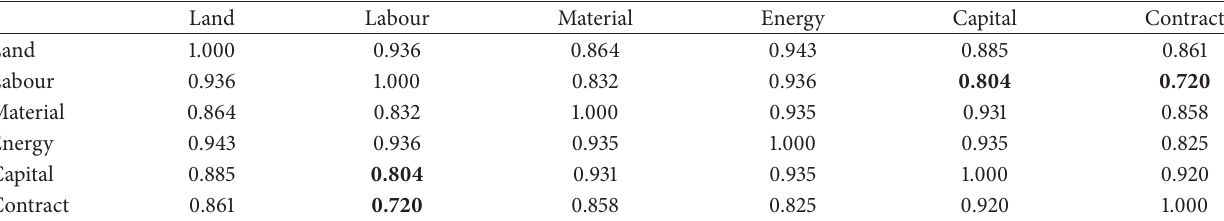
Table 5: Pearson correlation among input variables ( 𝑁 = 108